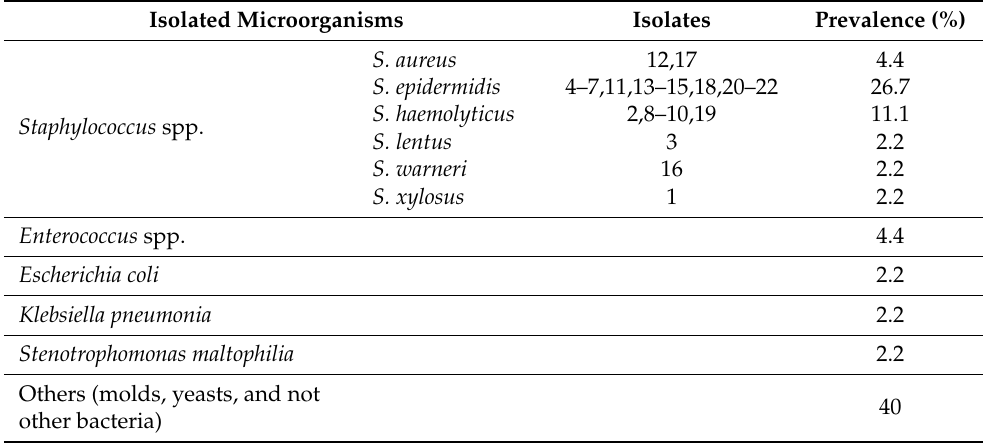
Table 1. Prevalence of isolated microorganisms in the studied PVCs. Isolated Microorganisms Isolates Prevalence (%)